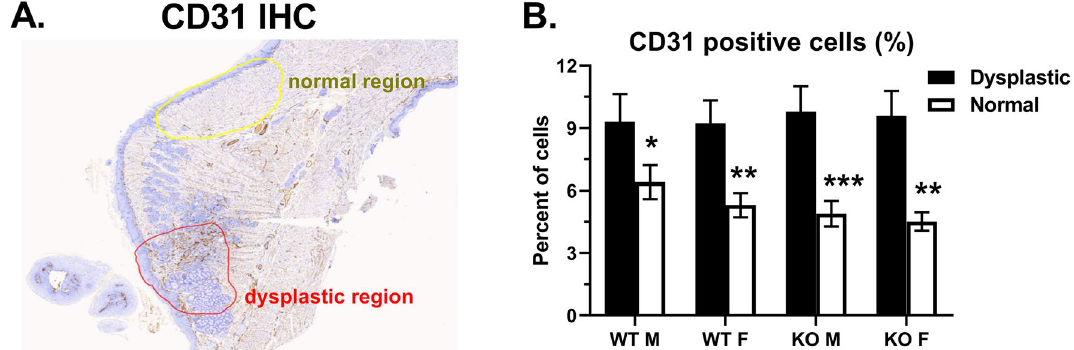
Figure 3. Dysplastic regions have increased CD31 expression independently of GPR68. Tongue sections from week 22–24 were stained for CD31 by immunohistochemistry (IHC). ( A ) Representative stain delineating the dysplastic region (red outline) from normal region (yellow). ( B ) Percent of cells staining positive for CD31 within the dysplastic (closed bar) or normal (open bar) regions. Data are from the same experiments described in Fig. 1 (* P < 0.05; ** P < 0.01; *** P <